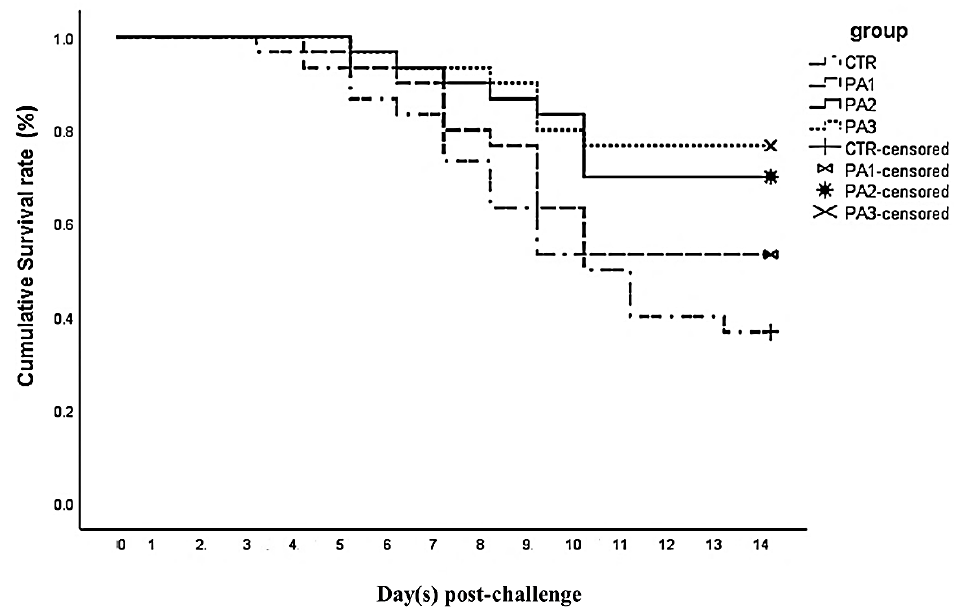
Figure 4. Survival rate (%) of common carp fed 100, 200 and 400 mg P. australis extract /kg diet and challenged with A. hydrophila . Differences between groups were examined using the log-rank test.